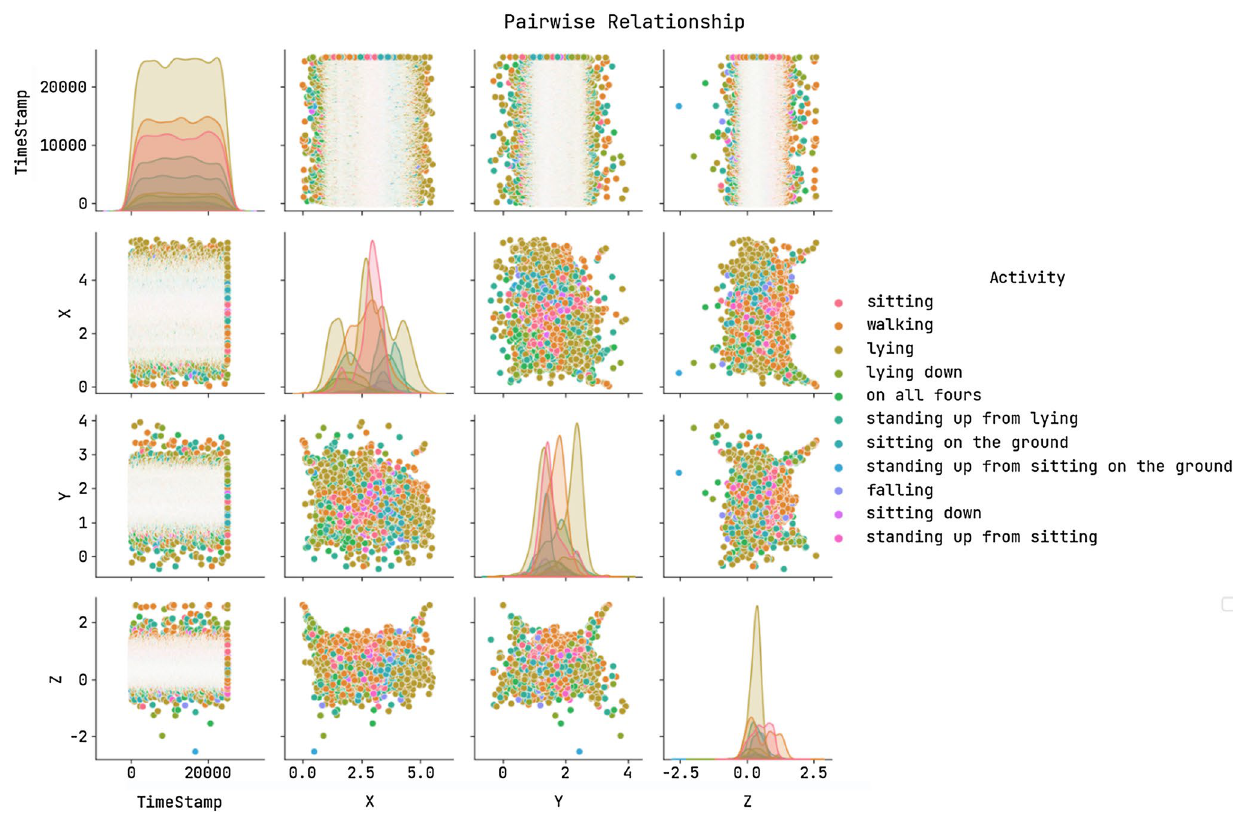
Fig. 4 Pairwise relationship of class labels in localization dataset